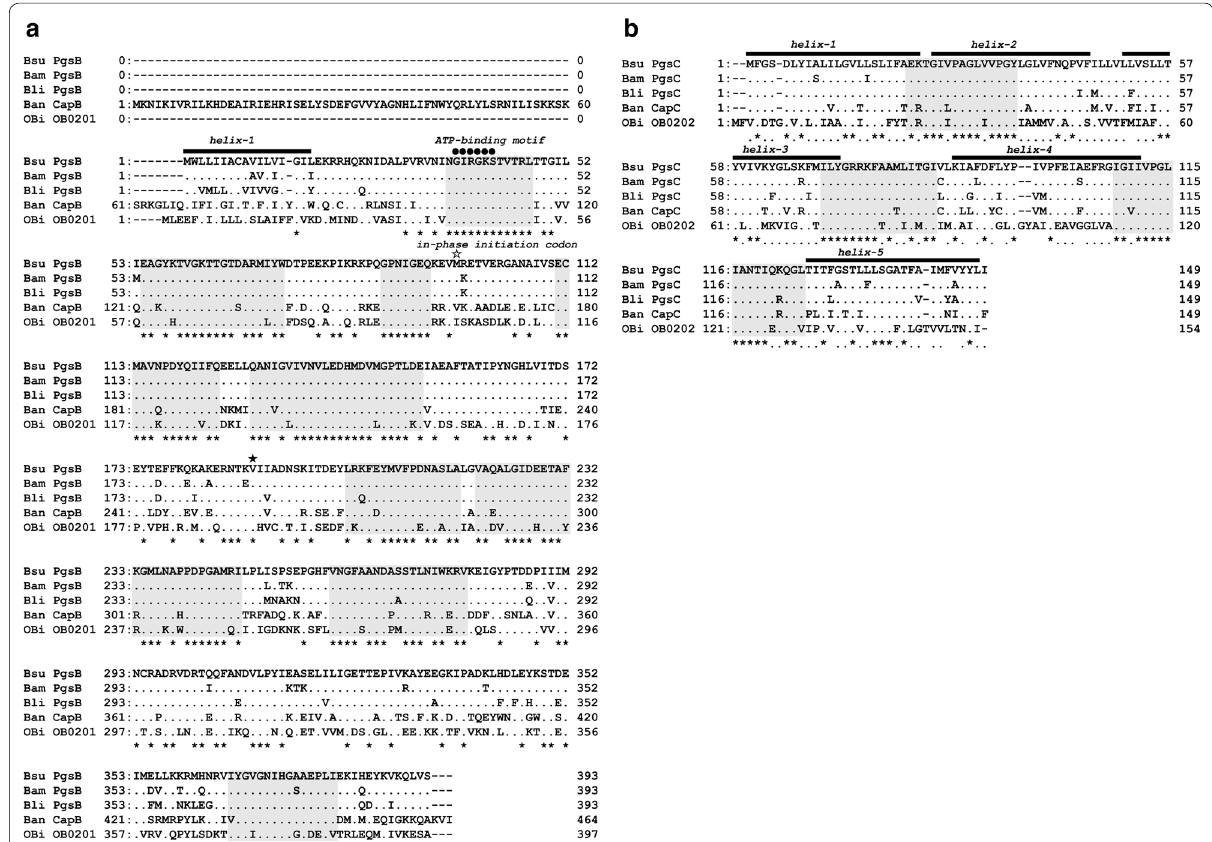
Fig. 3 Multiple alignments of a PgsB and b PgsC proteins. Sequence alignments were performed using the GENETYX program. Identical residues are shown by periods (.) and sites with 100% homology are marked with asterisks (*) on the bottom of the line. Predicted consensus sequences are shaded in Gray tones. Secondary structure prediction was performed using the SOSUI program. Predicted transmembrane helix structures are shown as black lines on the tops of lines. Symbols: closed circles, ATP-binding motif; opened star, the initiation codon of in-phase overlapping pgsB genes of B. subtilis ; closed star, the initiation codon of in-phase overlapping capB genes of B. anthracis